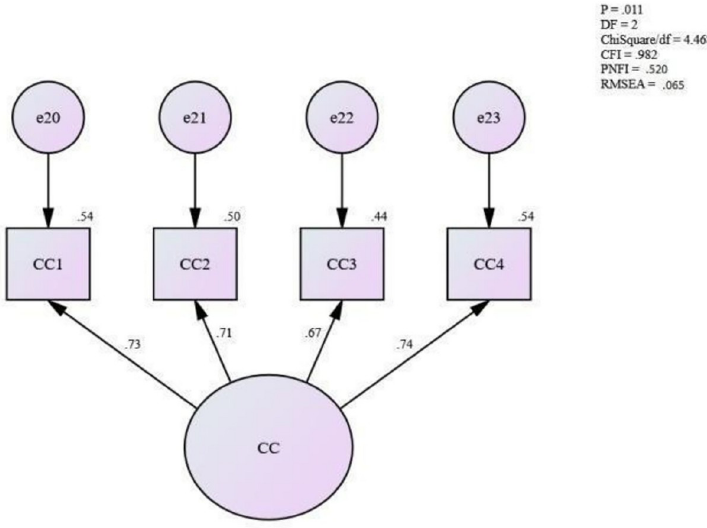
Fig 4. Measurement model for accessibility & availability of various types of